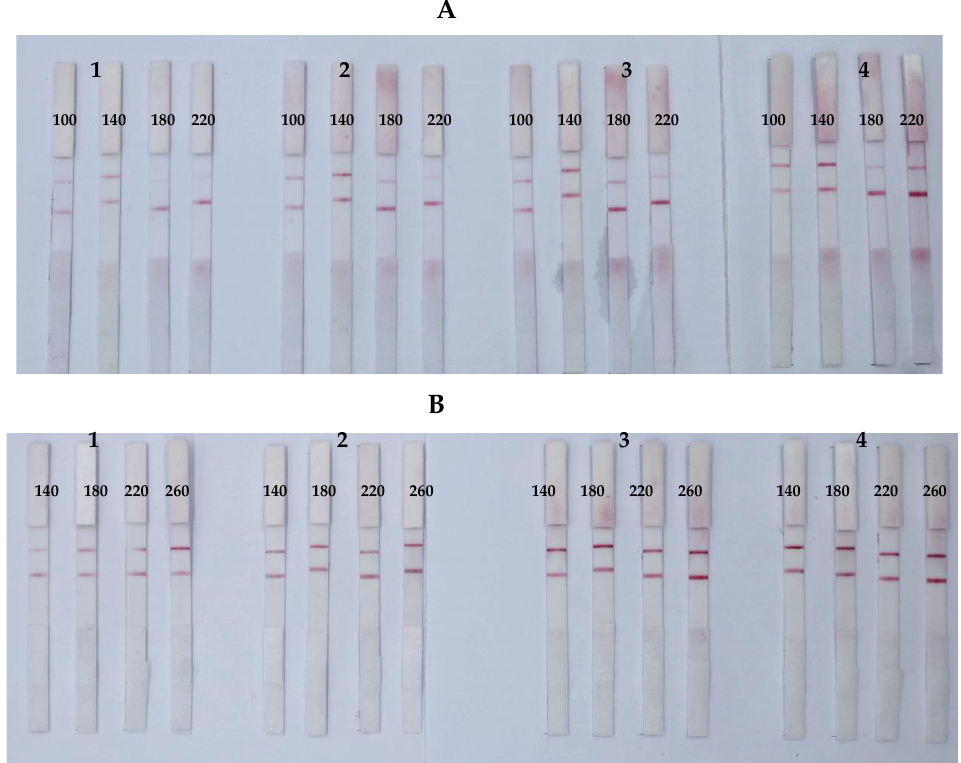
Figure 4. Optimization of the amount of GNP-labeled antibody and the concentration of antigen ICSs of ZEN ( A ), and T-2 ( B ). The amounts of GNP-labelled antibodies were 1, 2, 3, and 4 μL. The concentrations of ZEN-BSA were 100, 140, 180, and 220 μg/mL, and the concentrations of T-2-BSA were 140, 180, 220, and 260 μg/mL.